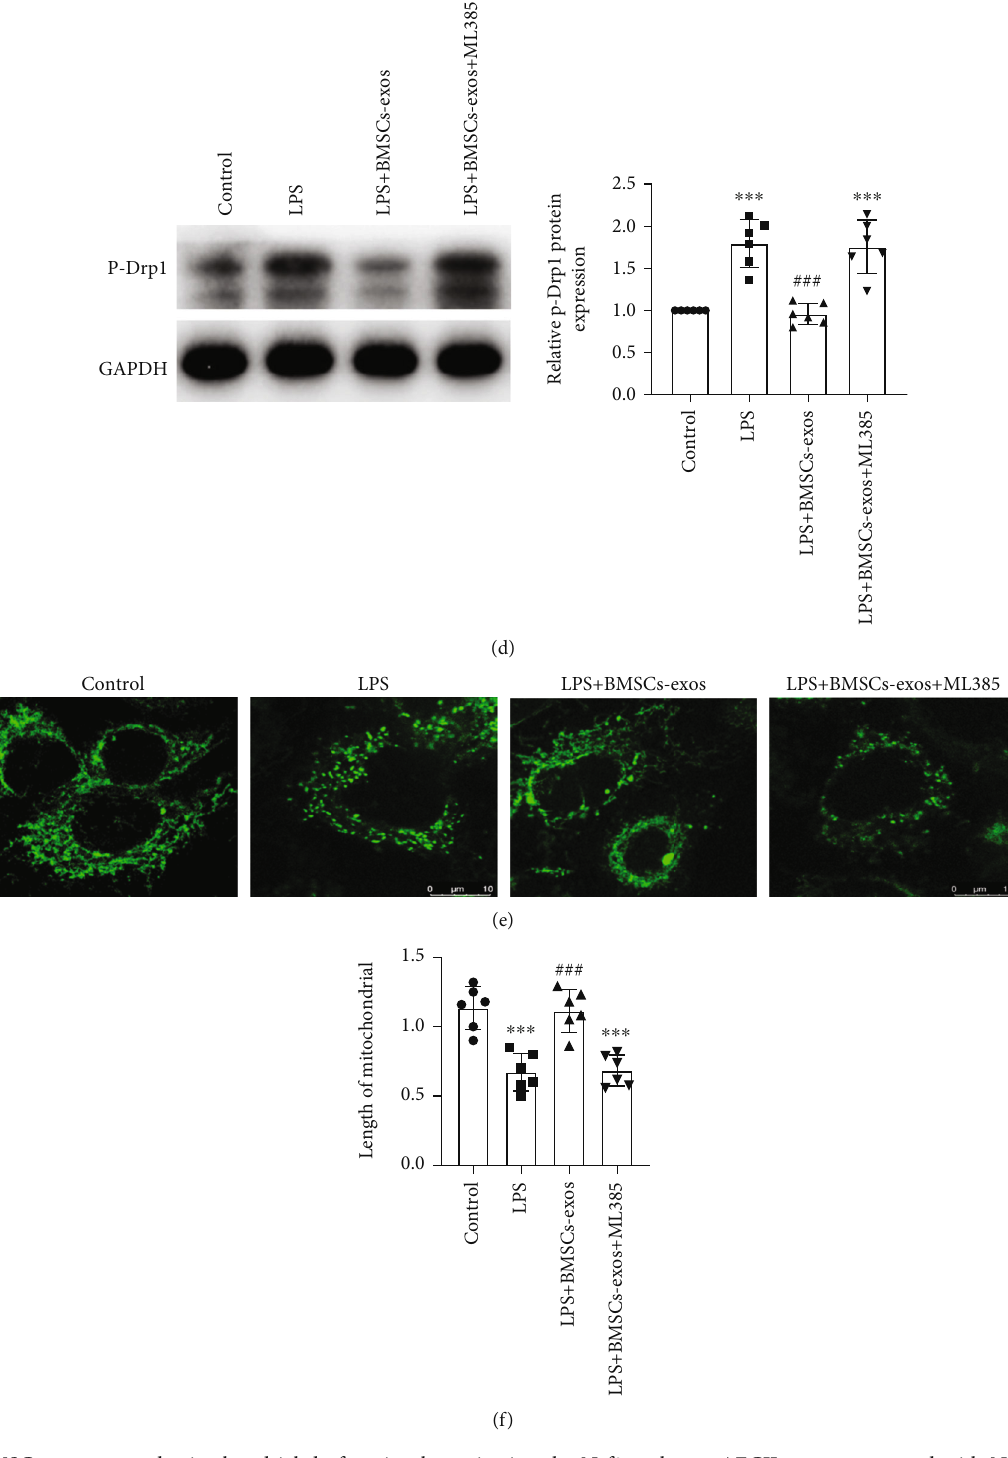
Figure 3: BMSC-exos reversed mitochondrial dysfunction by activating the Nrf2 pathway. AECIIs were pretreated with Nrf2 inhibitor- ML385 (20 μ M) for 30min, followed by LPS (25 μ g/ml) for 1 hour, and subsequently cocultured with BMSC-exos (100 μ g/ml) for 48 hours. (a, b) Expressions of Nrf2, PGC-1 α , Nrf1, and Tfam proteins were detected with western blotting. (c) Mitochondrial ATP content in AECIIs was measured with an ATP fl uorometric assay kit. (d) Expression of the p-Drp1 protein was detected by western blotting. (e) MitoTracker Green-stained mitochondrial morphology in AECIIs was observed with immuno fl uorescence. (f) The average length of the mitochondria in each group was analyzed. Data are represented as mean ± SD , n = 6 per group. NS: nonsigni fi cance; ∗∗∗ P < 0 : 001 vs. the control group; ### P < 0 : 001 vs. the LPS